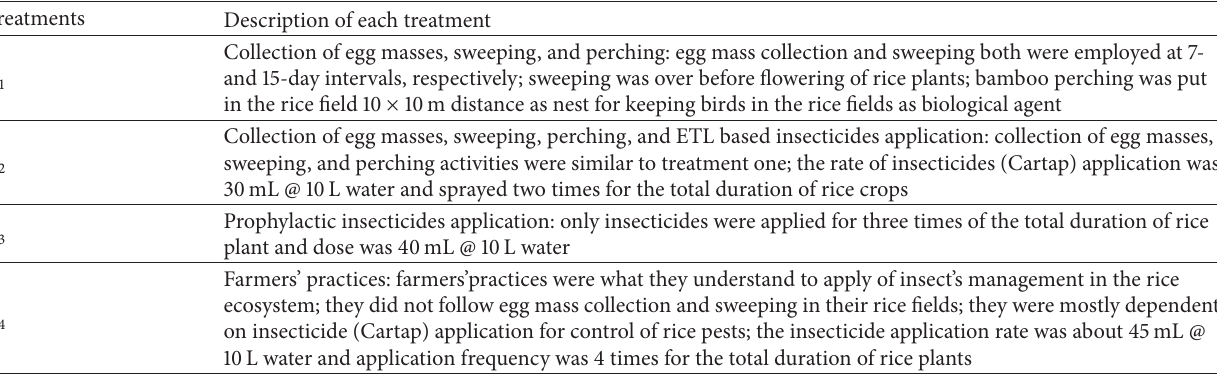
Table 1: Details of treatments in the rice agroecosystem in 2010-11.